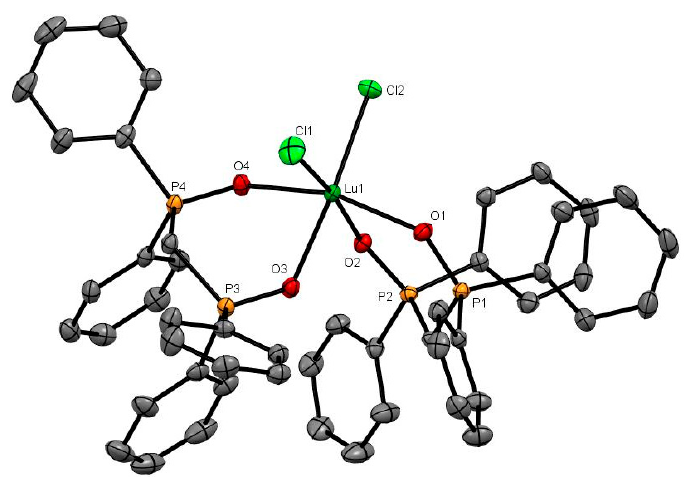
Figure 5. The cation in [Lu(dppmO 2 ) 2 Cl 2 ]Cl.